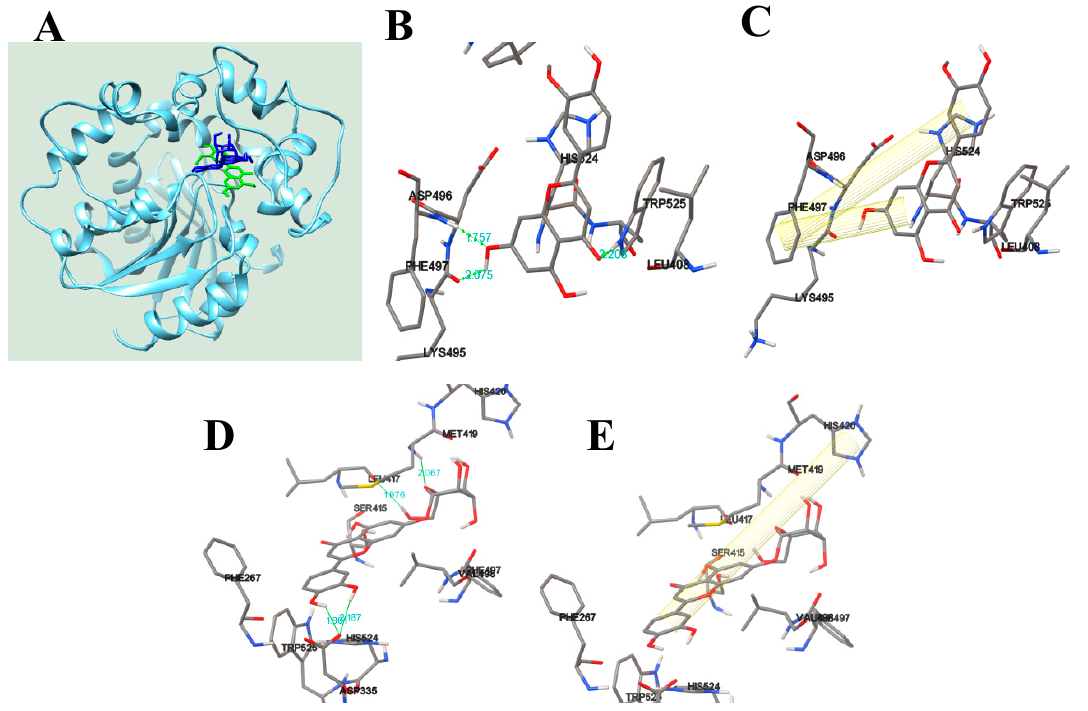
Figure 3. Predicted docking poses of 1 (green) and 2 (blue) into sEH ( A ). The hydrogen bond ( B ) and π - π interaction ( C ) of sEH with 1 . The hydrogen bond ( D ) and π - π interaction ( E ) between sEH and 2 . Table 2. Interaction and binding energy of sEH with flavonoids ( 1 and 2 ).